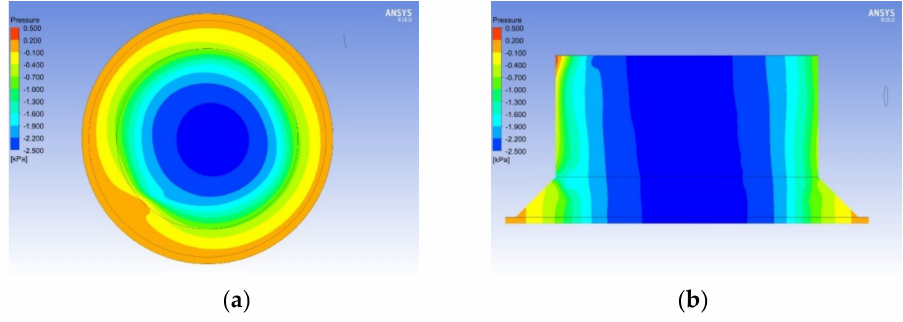
Figure 4. Pressure distribution of vortex gripper’s chamber. ( a ) The lower boundary surface of the gripper ( b ) Longitudinal